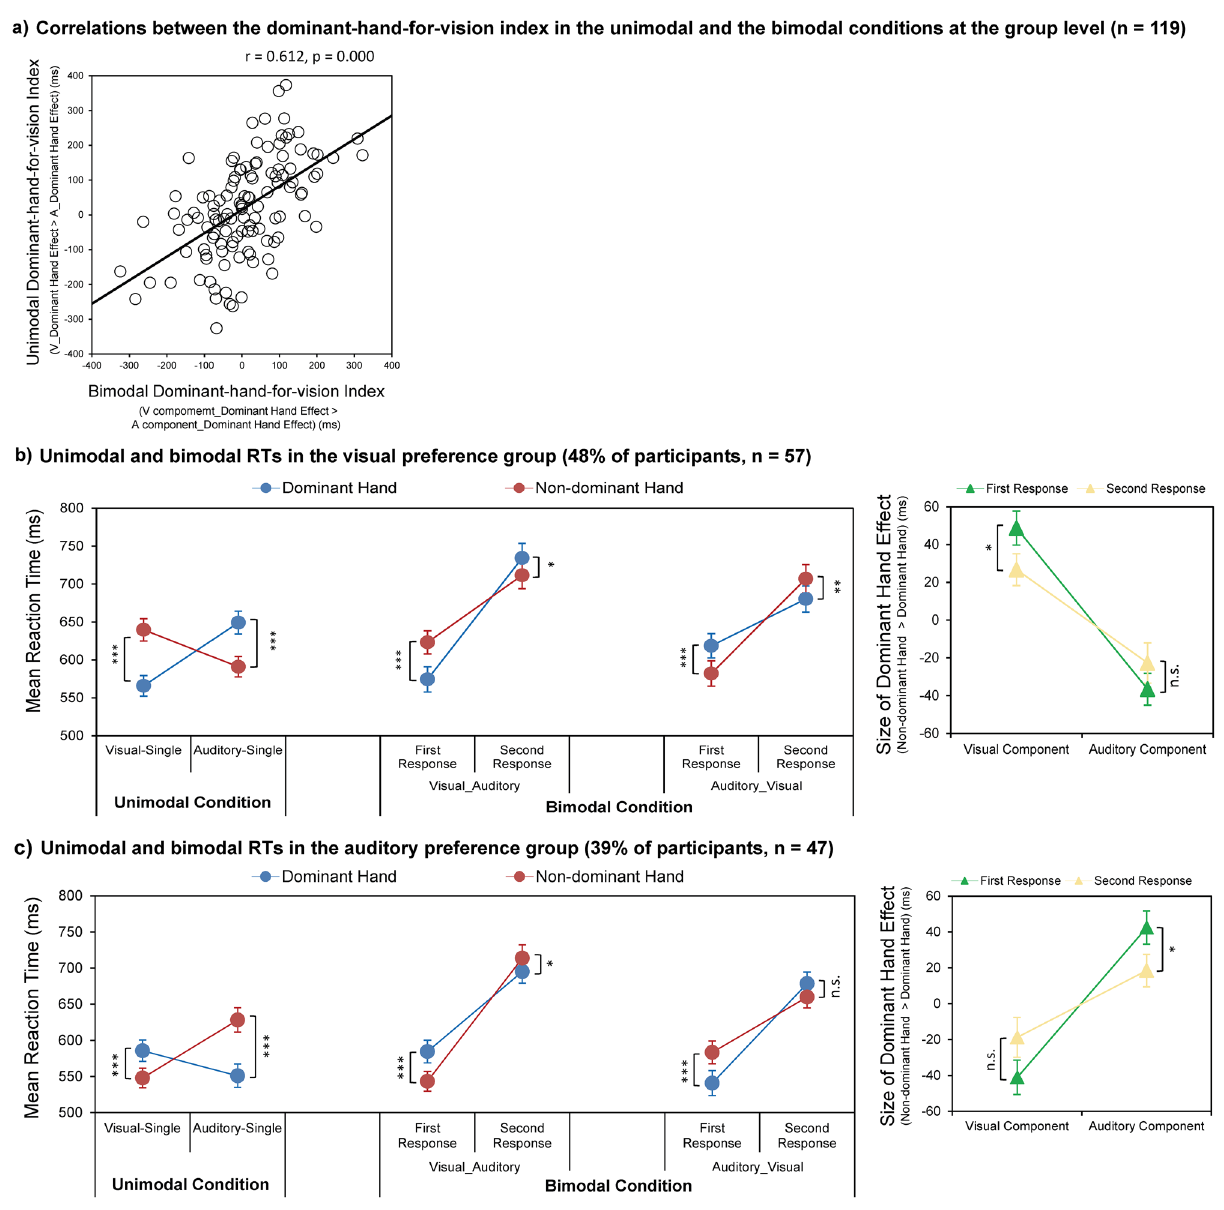
Figure 3. Two sub-groups with the opposite and stable preferential link between the visual vs. auditory modality and the dominant vs. non-dominant hand. ( a ) Correlations between the dominant-hand-for-vision index in the unimodal and the bimodal conditions for the whole group. ( b ) and ( c ) represented the unimodal and bimodal RT results for the visual preference group and the auditory preference group, respectively: left part of the Left panel, RTs in the unimodal trials are shown as a function of the sensory modality (visual vs. auditory) and the response hand (dominant vs. non-dominant hand); right part of the Left panel, RTs to the visual and auditory components of the bimodal trials are shown as a function of the response order (first vs. second response) and the response hand (dominant vs. non-dominant hand) for the VA and AV trials; Right panel, The simple effects for the significant sensory dominance*response order*response hand interaction in the bimodal condition. The dominant hand effect size is shown as a function of the sensory modality (visual vs. auditory) and the response order (first vs. second response). *** p < 0.001, ** p < 0.01, * p < 0.05. The error bars show standard errors of the sensory dominance was significant, F (1,118) = 26.07, p < 0.001, η p2 = 0.181, indicating that RTs in the AV tri- als (633 ± 10 ms) were significantly faster than RTs in the VA trials (649 ± 10 ms). Consistent with the definition of bimodal trials, the main effect of the response order was significant, F (1,118) = 245.64, p < 0.001, η p2 = 0.675, with faster first responses (583 ± 10 ms) than the second responses (699 ± 11 ms). The two-way interaction be- tween the sensory dominance and the response order was significant, F (1,118) = 68.44, p < 0.001, η p 2 = 0.367. Fur- ther planned t tests on simple effects showed that the RT difference between the second and the first response